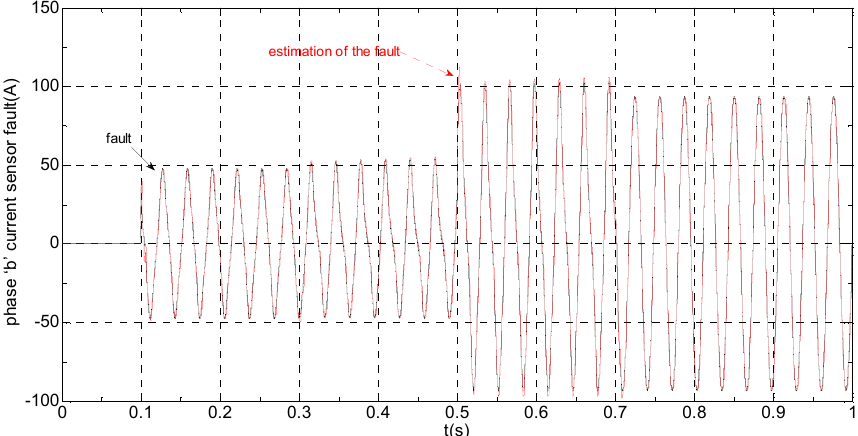
Figure 13. The current sensor fault and its reconstruction in phase “b”.